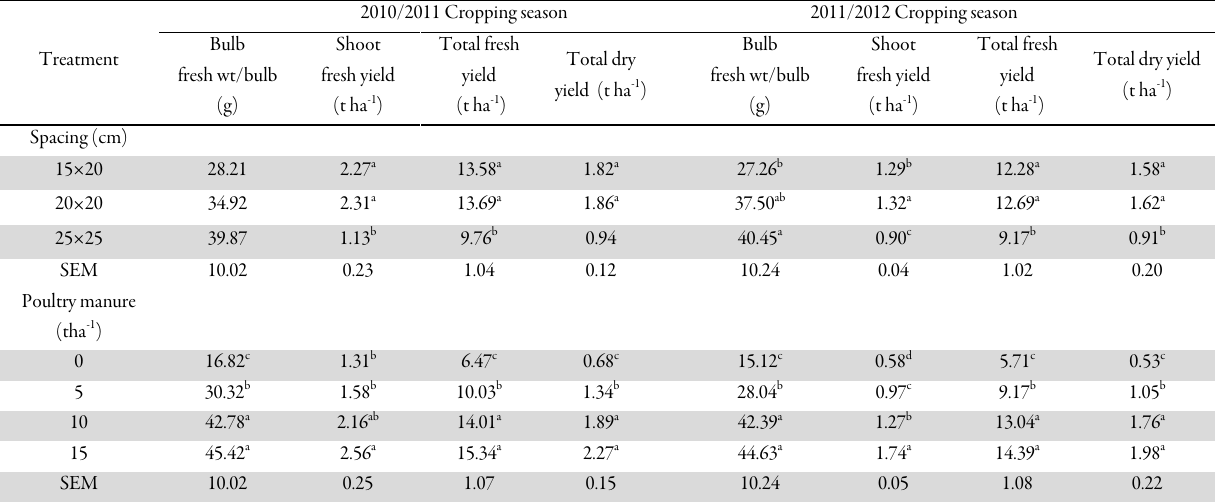
Table 3. Effect of poultry manure and spacing on yield and yield components of onion 2010/2011 and 2011/2012 dry cropping seasons